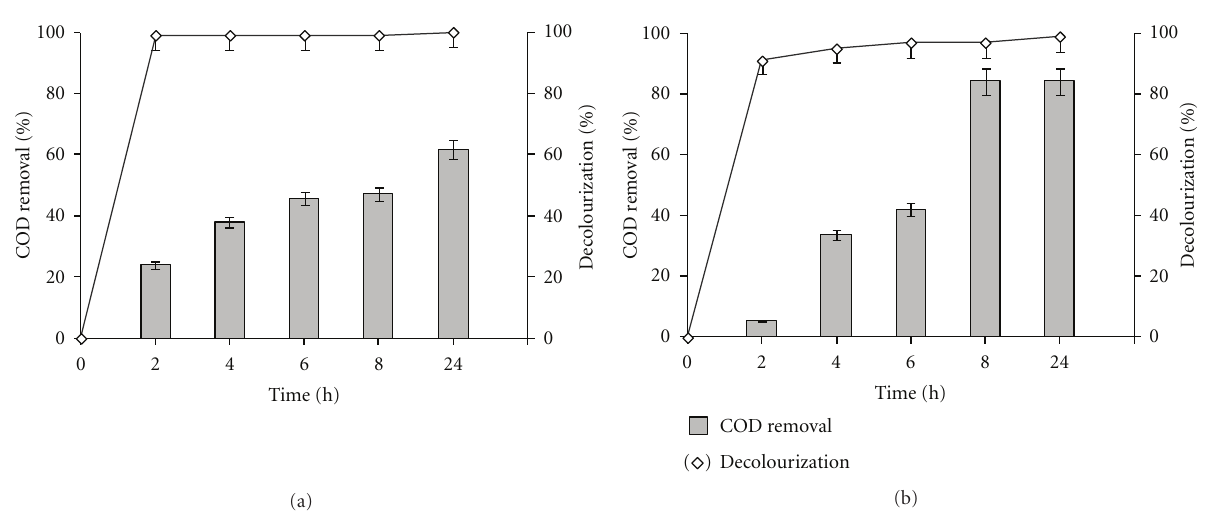
Percentages of decolorization of crystal violet (CV) and malachite green (MG) were calculated after (2, 4, 6, 8, and 24 hours) culture at 35 ◦ C under agitation conditions, with yeast extract (0.1%) and glucose (7mM) as an additional carbon source. Dyes were present at a concentration 50mg/L. S 1 , Agrobacterium radiobacter ; S 2 , Bacillus spp. ; S 3 , Sphingomonas paucimobilis ; S 4 , Aeromonas hydrophila ; S 5 , bacterial consortium (CM-4).